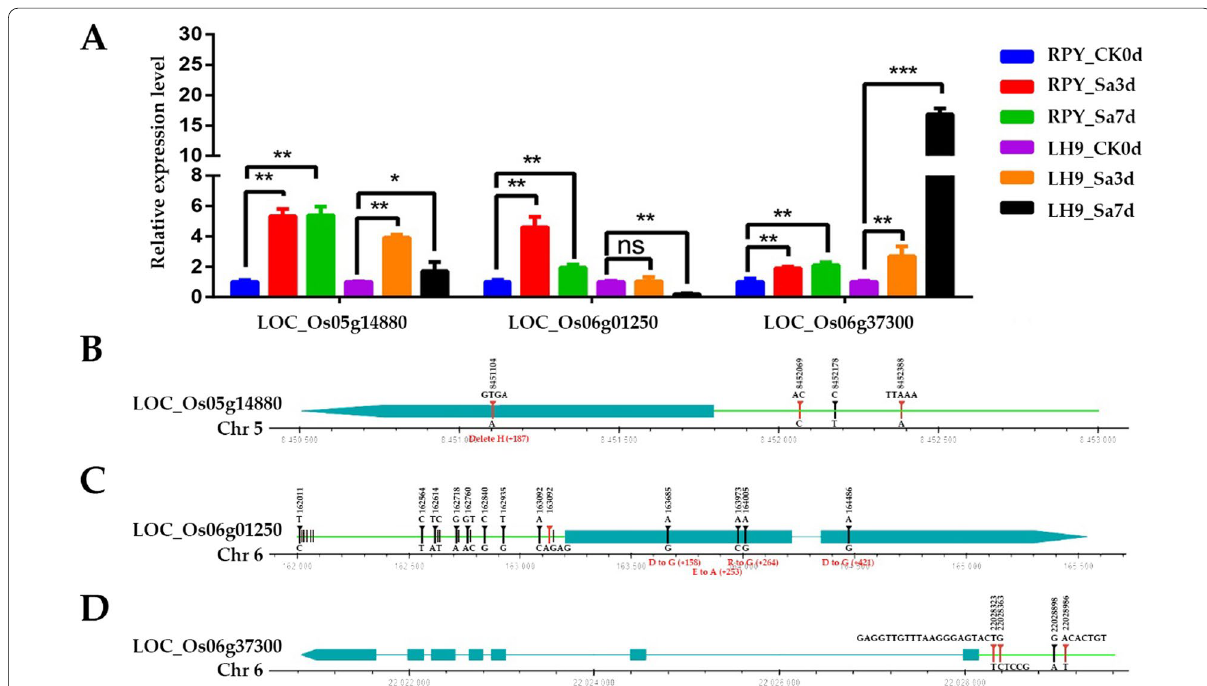
Fig. 8 Gene expression changes and sequence alignments of LOC_Os05g14880 , LOC_Os06g01250 , and LOC_Os06g37300 between RPY geng and Luohui 9. A Changes in gene expression levels in the roots of RPY geng and Luohui 9 after 3 and 7 days of salt stress treatment (100 mM NaCl Yoshida solution for salt stress treatment); B Sequence alignment result of LOC_Os05g14880 ; C Sequence alignment result of LOC_Os06g01250 ; D Sequence alignment result of LOC_Os06g37300 . Note RPY means RPY geng; LH9 means Luohui 9; CK0d means control (0 day); Sa3d and Sa7d mean salt treatment for 3 days and for 7 days, respectively. The upper mutations belong to RPY geng and the lower mutations belong to Luohui 9 in B –